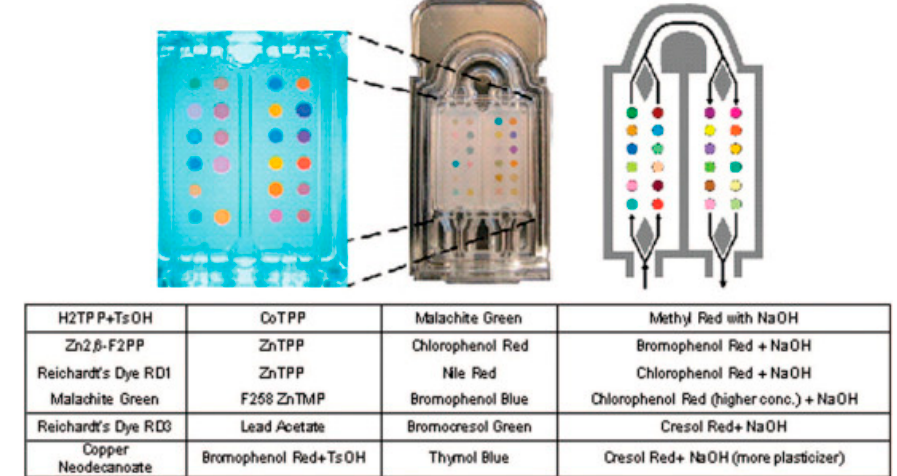
Figure 3. Image of the colorimetric sensor used in this study. Twenty-four chemically reactive colorants are printed on a disposable cartridge. The reactive colorants used in the studied array are listed as they appear on the cartridge. Exhaled breath is drawn across the cartridge in the direction shown. Used with permission from [74].